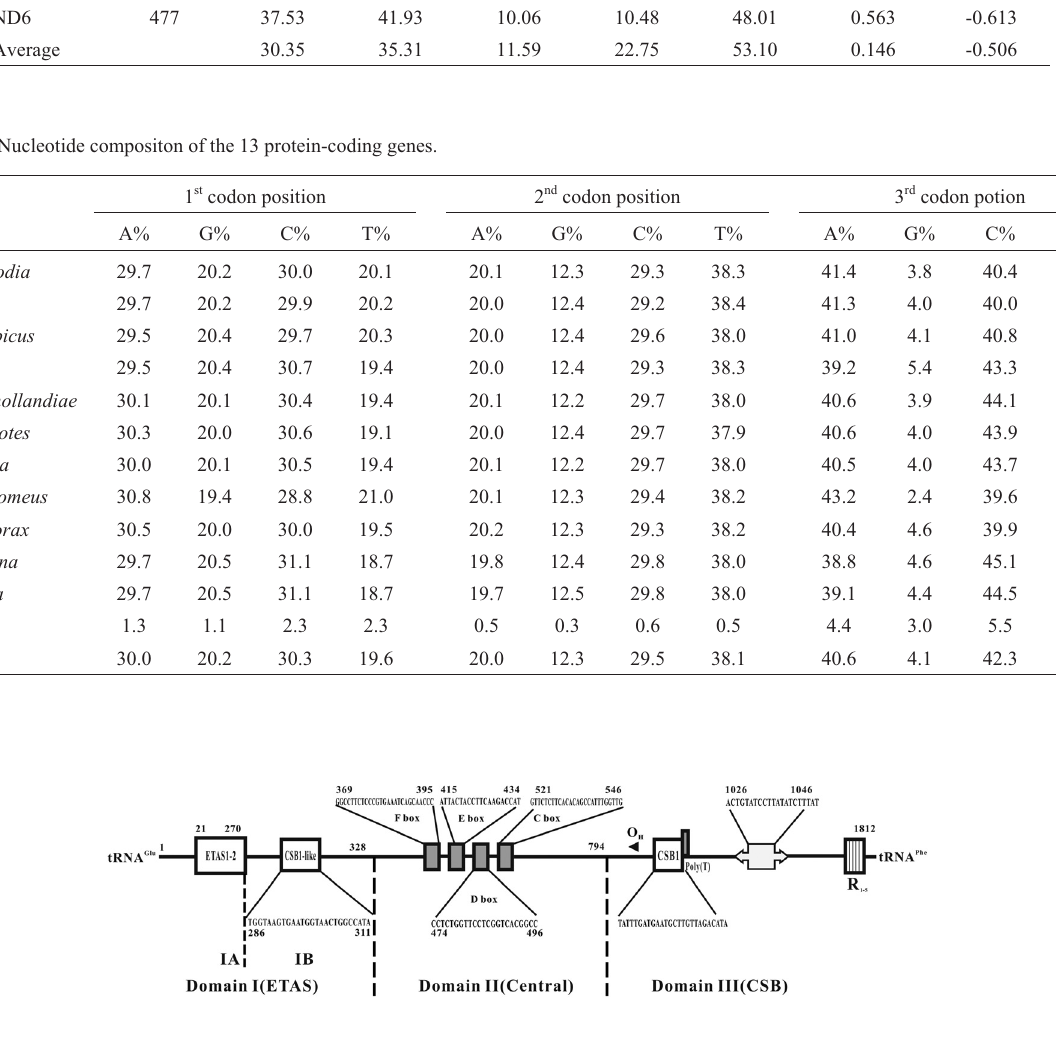
Figure 2 - Schematic representation of the control region in the mitogenome of E. garzetta . The first box represents the extended termination-associated sequences (ETAS1 and ETAS2). Boxes F, E, D and C represent the conserved sequence boxes in the central domain. CSB – conserved sequence block, CSB-like–asequencesimilartoCSB,LSPandHSP–light-strandandheavy-strandtranscriptionpromoters,respectively,andRs–tandemrepeatsinthe control